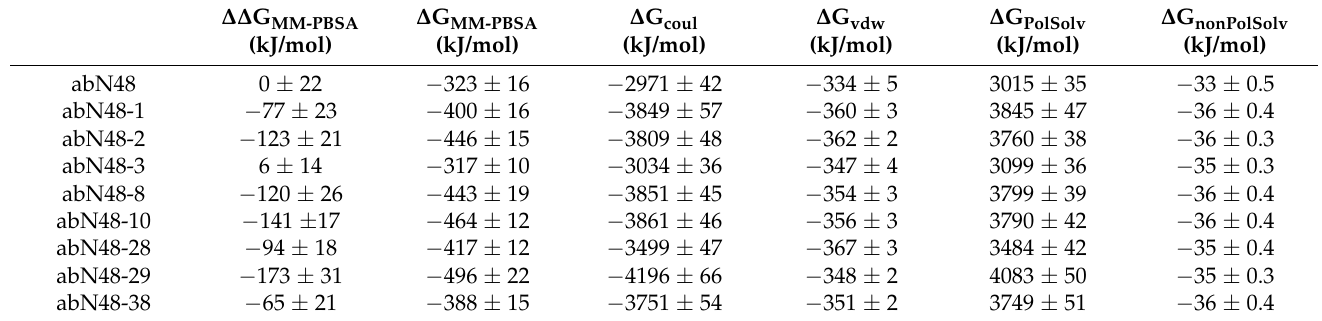
Table 1. Different contributions to the binding for the various antibodies produced by in vitro affinity maturation. Absolute values for ∆ G were obtained from the sum of the other contributions; the relative ∆∆ Gs were obtained as differences with the absolute ∆ G of abN48.